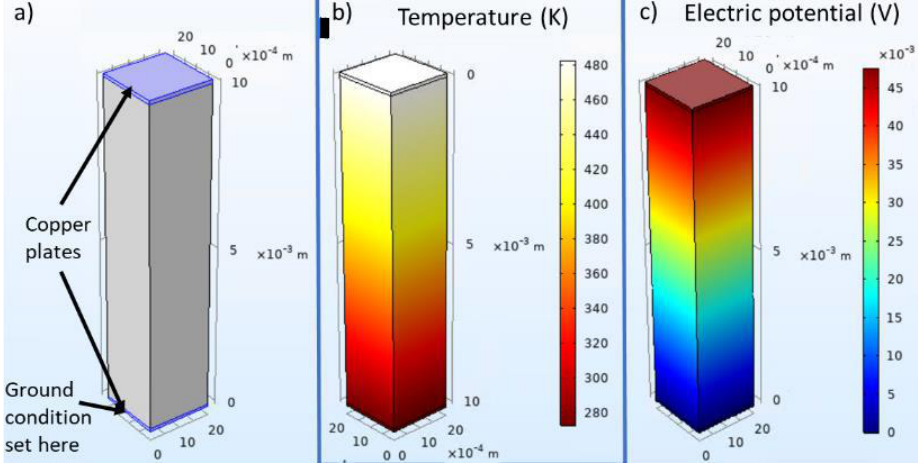
Figure 3. Single thermoelectric leg constructed on COMSOL displaying ( a ) dimensions, ( b ) temperature gradient, ( c ) electric